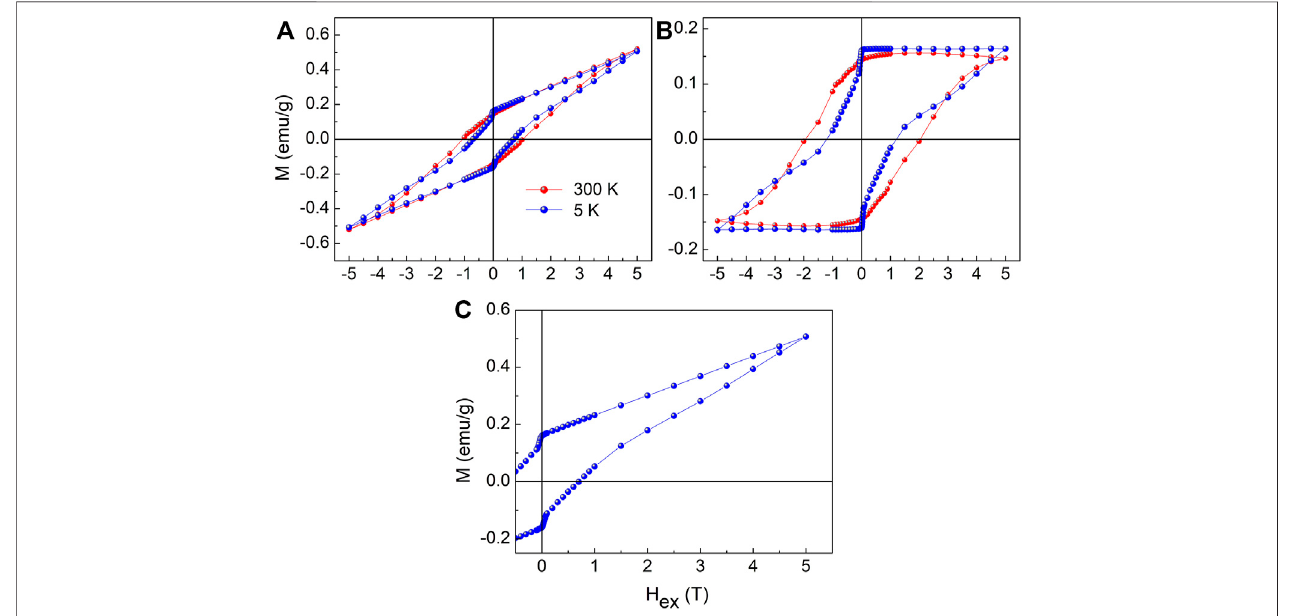
FIGURE 7 | (A) Magnetization hysteresis loops for the as-prepared BiFeO 3 measured at 5 K (blue line) and 300 K (red line). (B) The ferromagnetic components for the as-prepared BiFeO 3 extractedfrom its magnetization hysteresis loops measured at 5 K (blueline) and 300 K (redline). (C) The M ( H ext ) curvemeasured at 5 K for the as-prepared BiFeO 3 in the fi eld region of − 0.5 T < H ext < 5 T showing the wasp-waisted